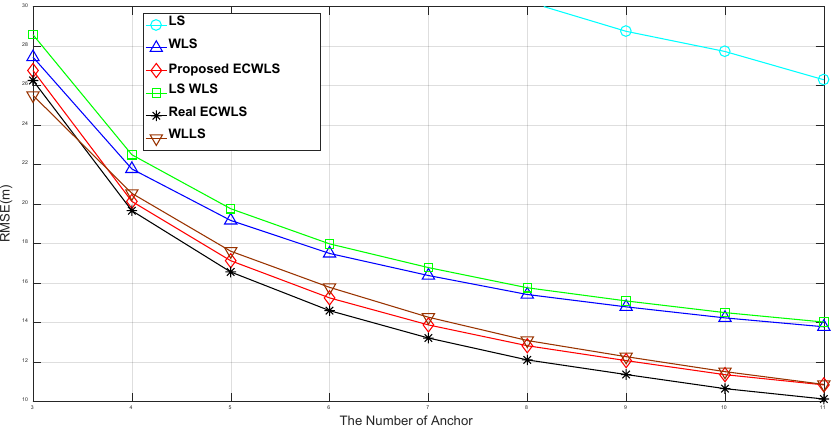
Figure 6. RMSE vs. the number of anchor nodes on a large